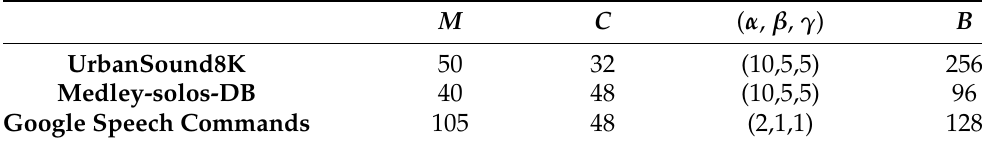
Table 2. APNet hyperparameters for each dataset: number of prototypes ( M ), number of channels in convolutional layers ( C ); training hyperparameters ( α , β , and γ ); and, batch size ( B ).